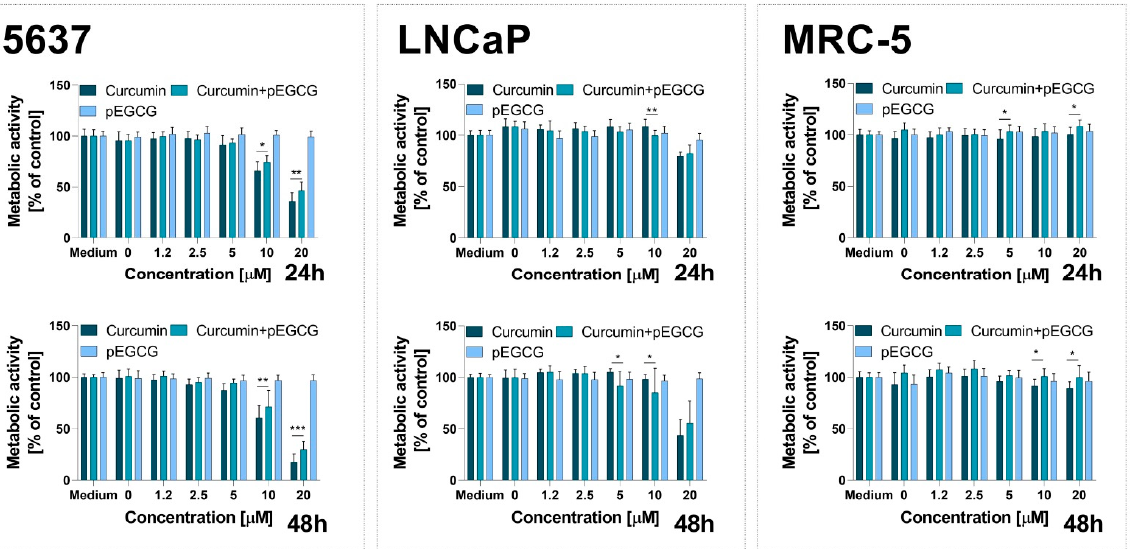
Figure 8. The comparison of curcumin, pEGCG, and combination of both compounds in liposomes against 5637, LNCaP, and MRC-5 cells. Data are expressed as the mean ± SD from three experiments. Statistical significance between groups was assessed by Tukey’s Comparison Test (* p < 0.05; ** p < 0.01, *** p <